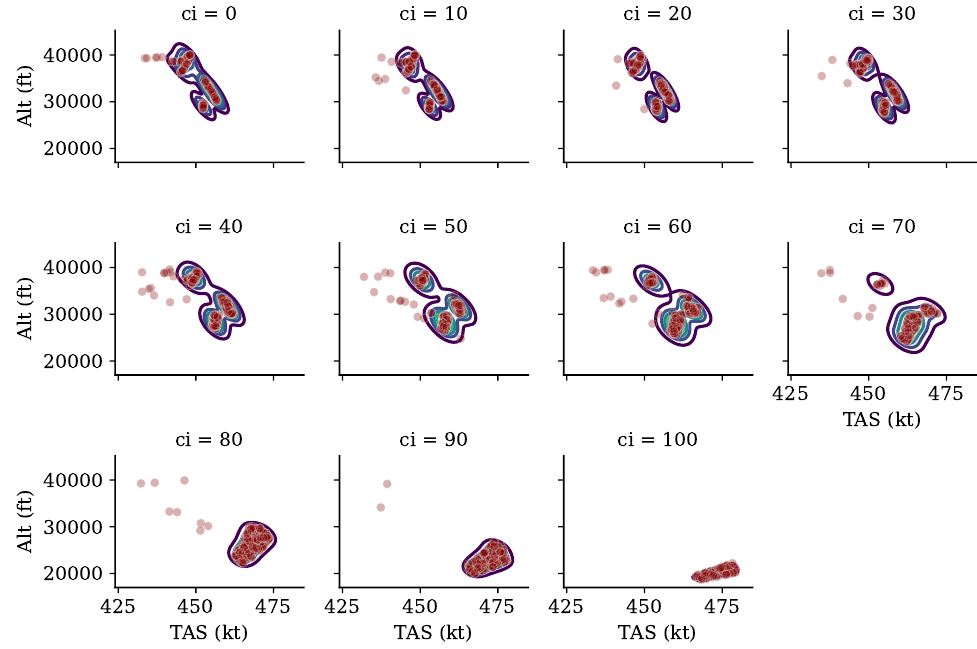
Figure 10. Distribution of cruise altitude and Mach number grouped by cost index.